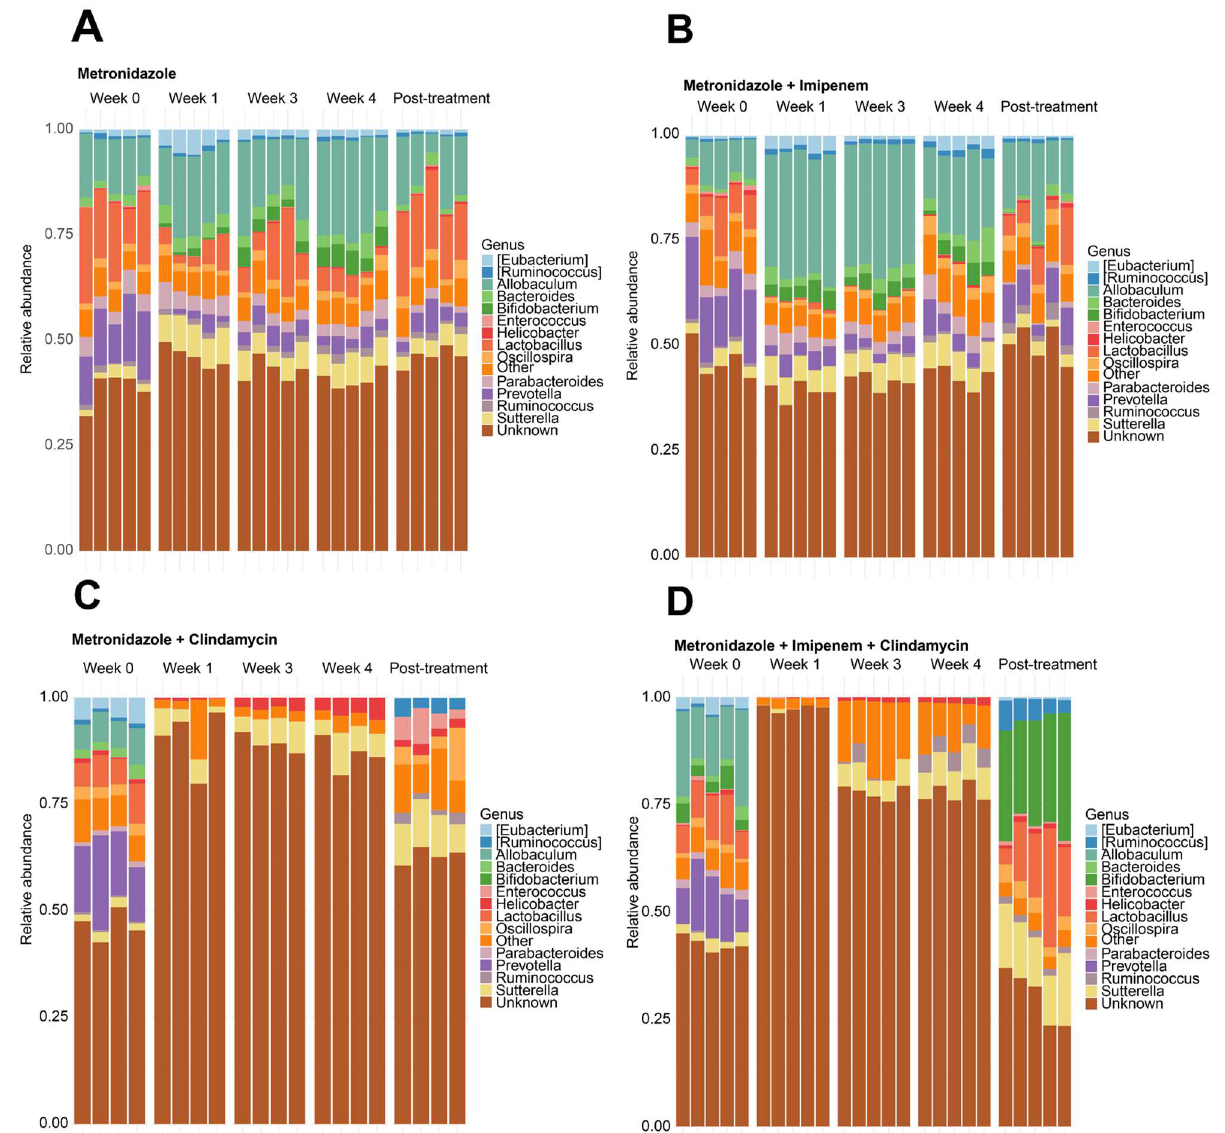
Figure 5. Stacked relative abundance plots at genus level for mice treated with ( A ) metronidazole ( B ) metronidazole + imipenem ( C ) metronidazole + clindamycin ( D ) metronidazole + imipenem + clindamycin.